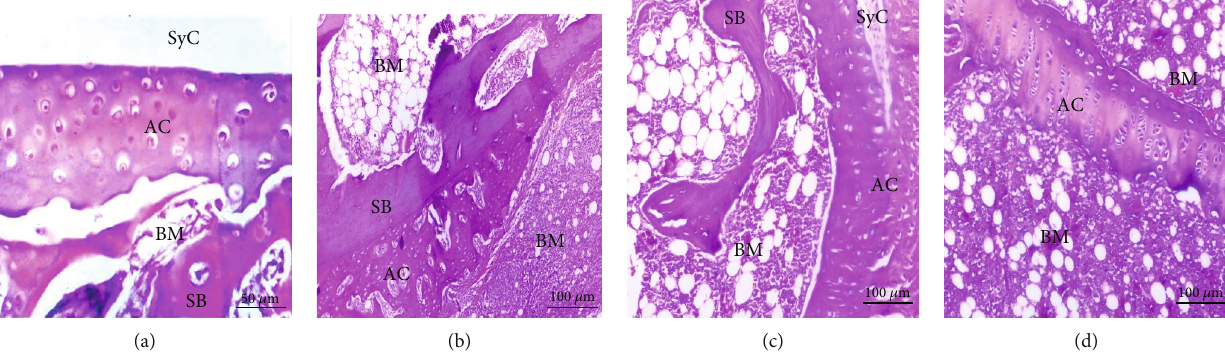
Figure 2: Photomicrographs of sections in the ankles of male rats from control groups: (a) water, (b) CMC, (c) curcumin, (d) stem cells showing normal articulating cartilage (AC), synovial cavity (SyC), sponge bone (SB), and bone marrow (BM) (H&E).